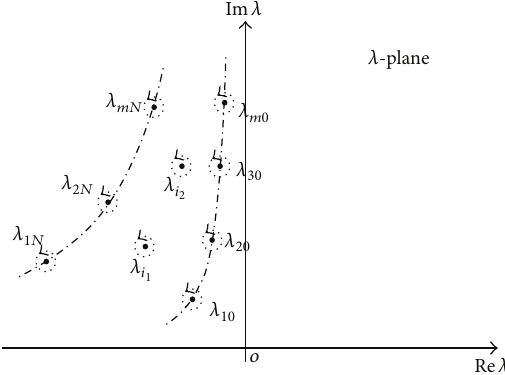
Figure 3: Final integration contour for the Sommerfeld